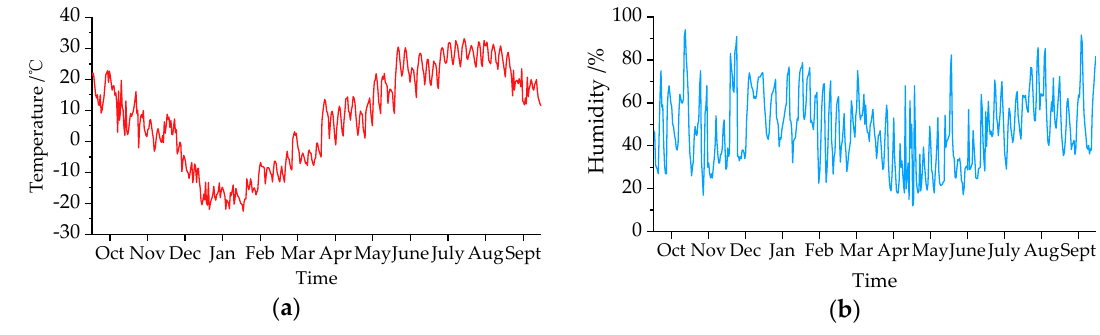
Figure 11. Environment parameters variations with months: ( a ) temperature; ( b ) humidity.